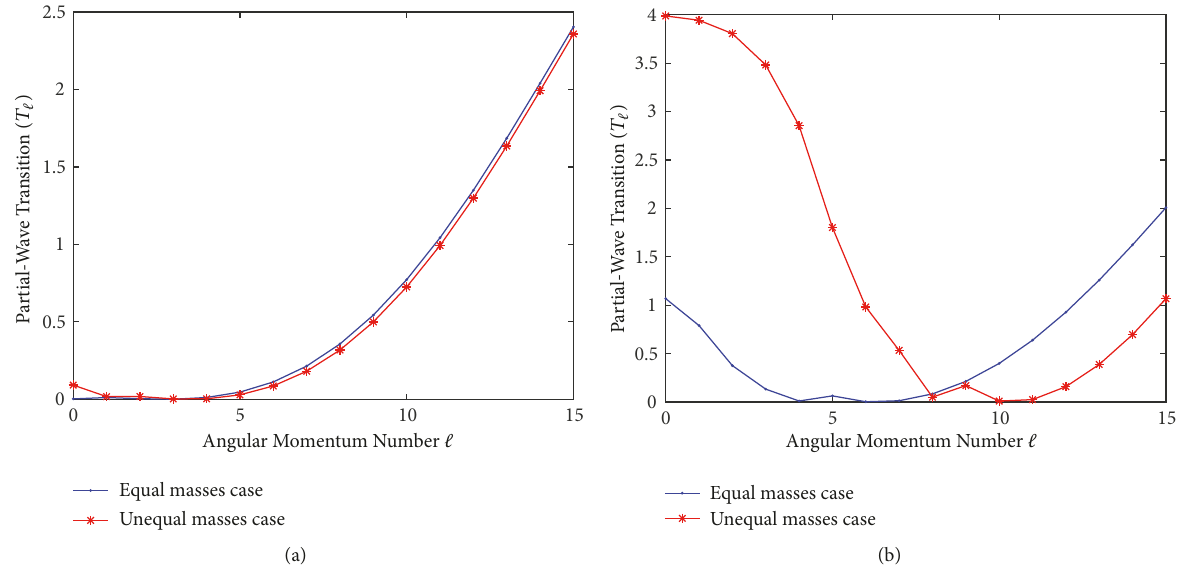
Figure 4: (a) Partial-wave transition for the spinless Salpeter equation with the Hellmann potential as a function of angular momentum quantum number 𝑙 with 𝑎 = −2,𝑏 = 0 , 𝐸 𝑛,𝑙 = 1,𝜌 = 0.5 . (b) Partial-wave transition for the spinless Salpeter equation with the Hellmann potential as a function of angular momentum quantum number 𝑙 with 𝑎 = 3,𝑏 = 0 , 𝐸 𝑛,𝑙 = 1, 𝜌 = 0.5 .